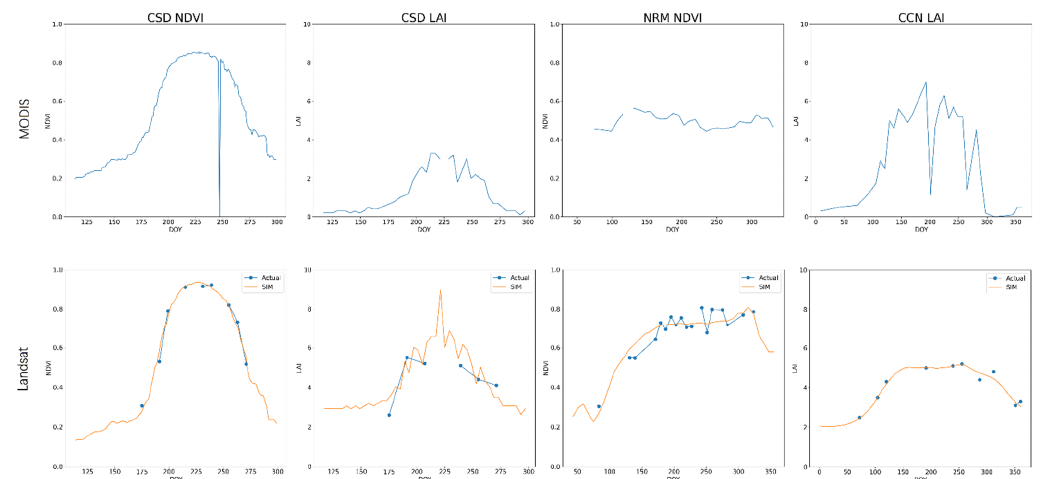
Figure 15. Temporal evolution of NDVI and LAI in one Moderate-resolution Imaging Spectroradiometer (MODIS)/Landsat pixel at three study areas.